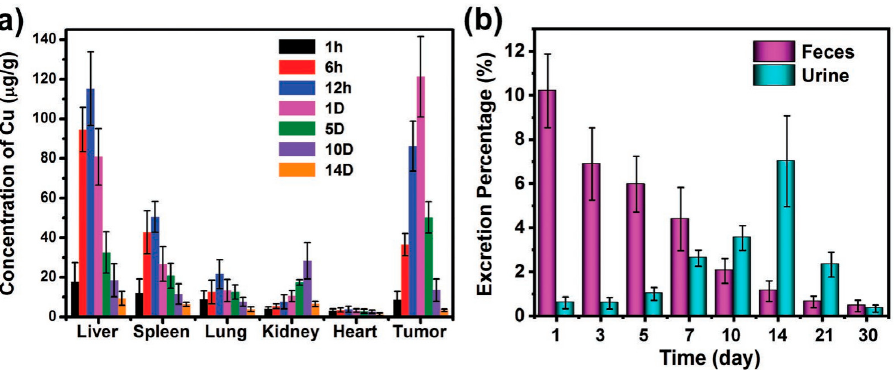
Figure 4. ( a ) Biodistribution of the nanoMOFs in vivo at different times after tail vein injection. ( b ) The percentage of excretion of nanoMOFs at different times after tail vein injection. Reproduced from Ref. [114] with permission from Wiley–VCH, copyright 2019.